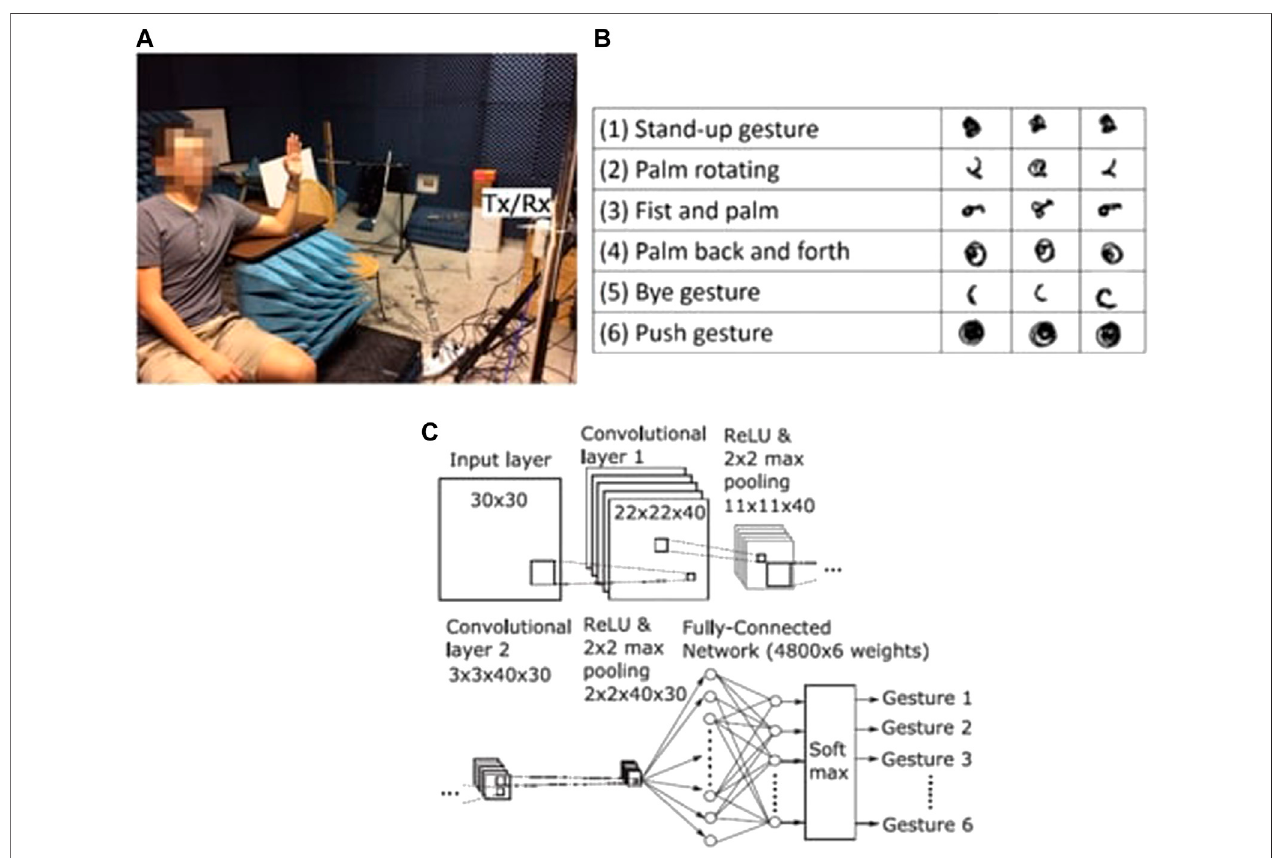
FIGURE11 | Radar-based hand gesture recognition. Experimental setup with subjectsin seated position in front ofthe radar system in an anechoic chamber, (A) , and example images of radar I/Q plots associated with gestures, (B) , and block diagram of CNN used of pattern recognition, (C) . From Sakamoto et al. (2018).